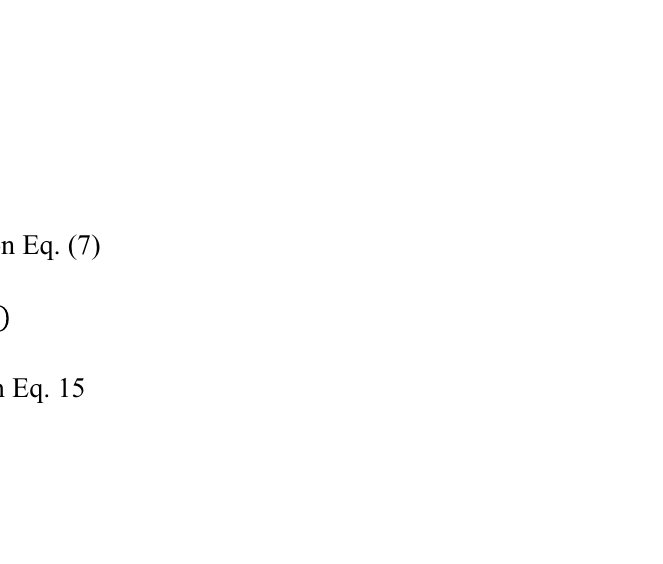
Algorithm 3 Pseudo-code of AEFA-CSR Initialization of Population size